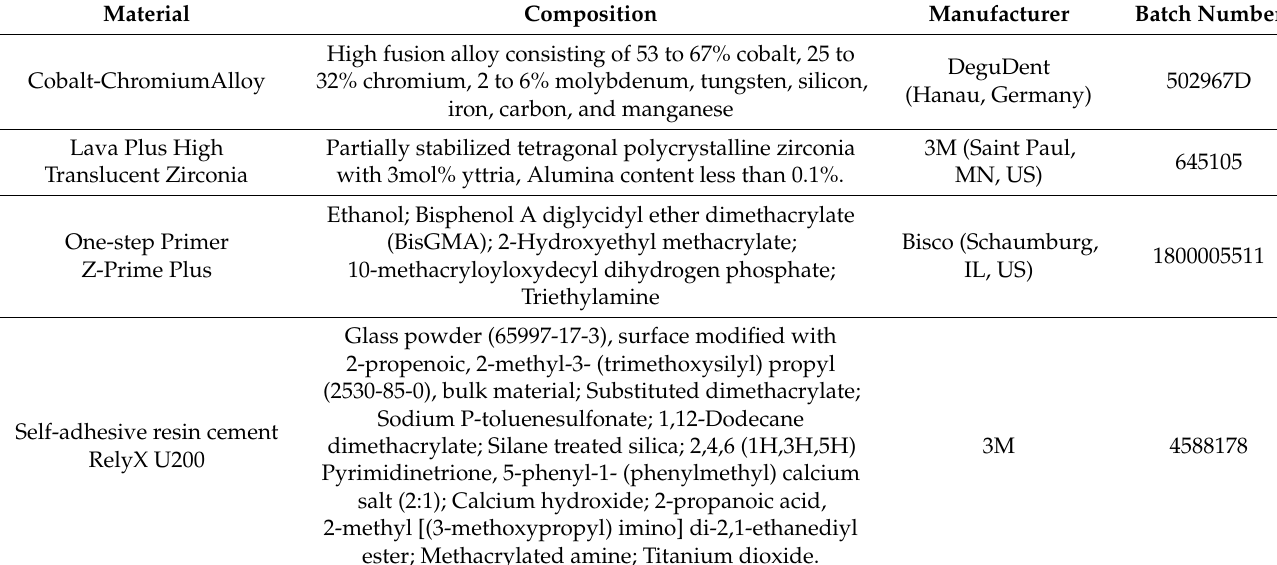
Table A1. List of materials, composition, manufacturers, and batch